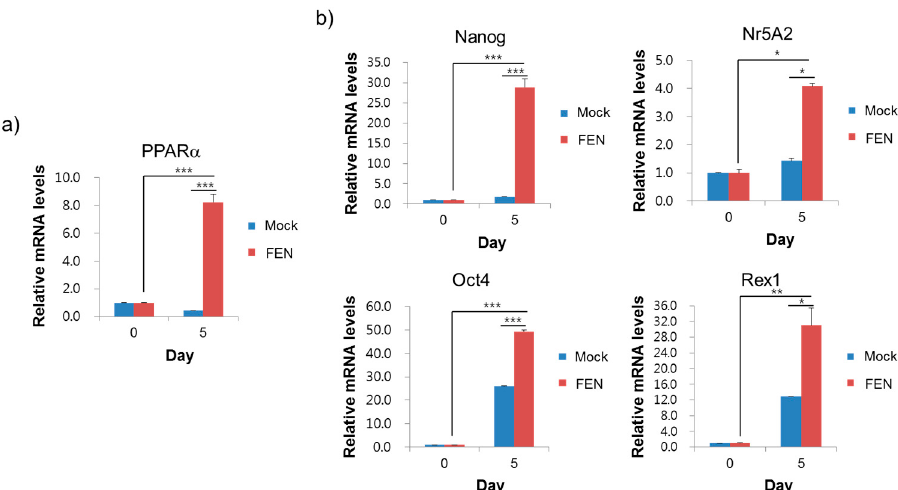
Figure 2. FEN significantly increases PPAR α and pluripotency-associated genes. ( a ) Expression of PPAR α in OSKM-induced cells with or without FEN 5 µ M for 5 days. The results were normalized to GAPDH and expressed as a fold-increase over Mock (DMSO, vehicle control). ( b ) Expression of the pluripotency-associated genes (Nanog, Nr5A2, Oct4, and Rex1) in OSKM-induced cells with or without FEN 5 µ M for 5 days. The results were normalized to GAPDH and expressed as a fold-increase over Mock (DMSO, vehicle control).